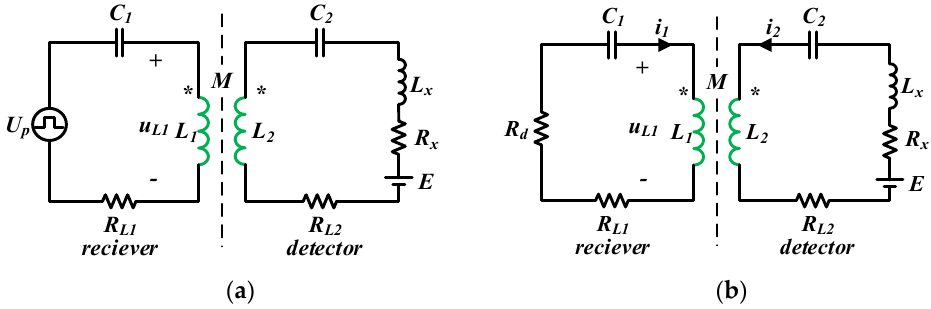
Figure 3. System equivalent circuit in different operation stages: ( a ) Energy injection stage; ( b ) De- tection stage.